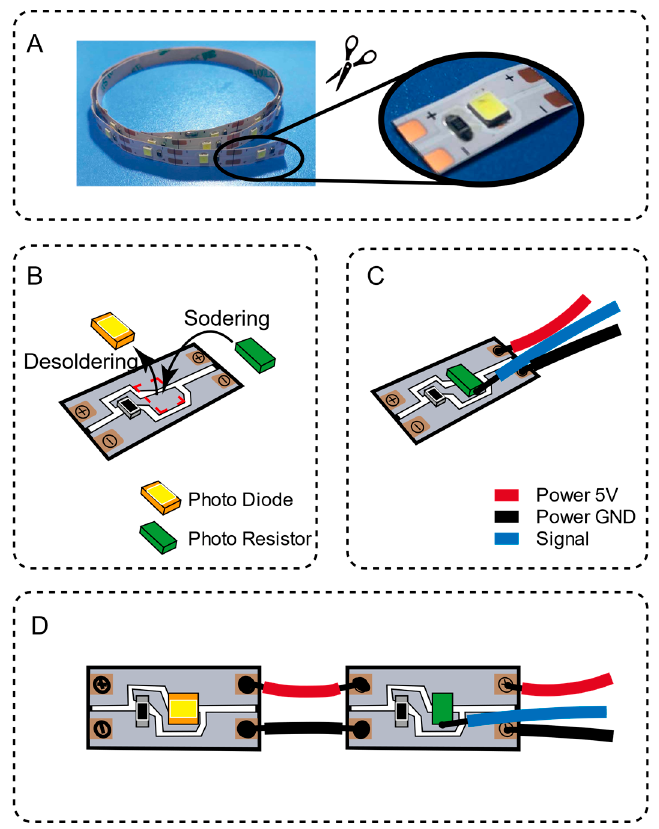
Figure 2. Fabrication of flexible circuit board inside the sensing unit. ( A ) cut out a single LED unit from the light strip; ( B ) replace the LED lamp beads with a photoresistor; ( C ) weld the power supply and signal wires; ( D ) weld the LED strip and the photoresistor strip together.